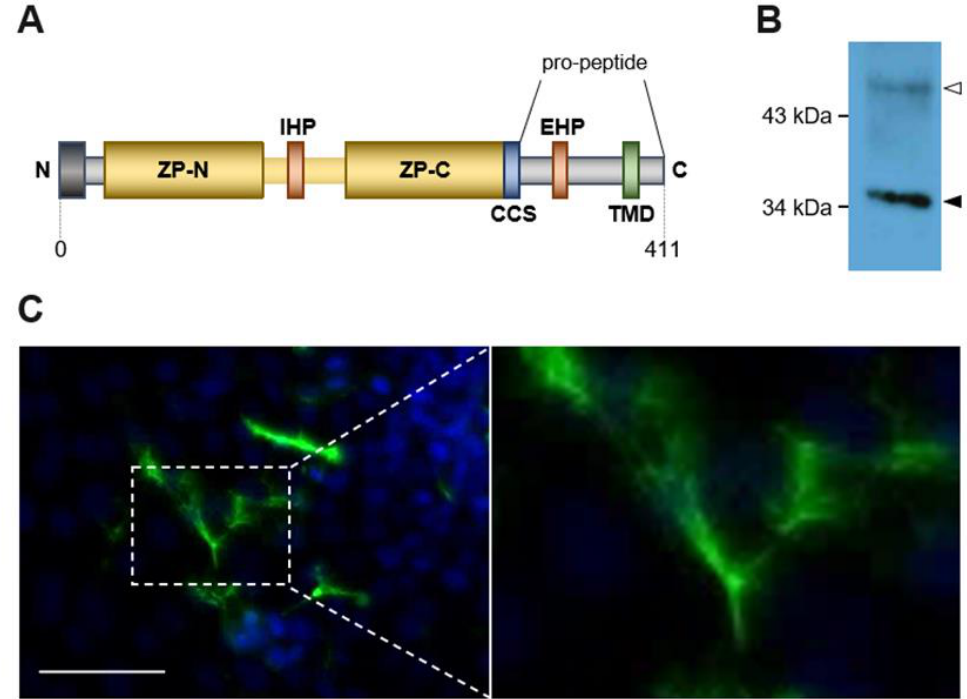
Figure 1. MDCK cells as a model to study ZPLD1. ( A ) Scheme of zebrafish ZPLD1 structure expected to contain a N-terminal signal peptide, a bipartite Zona Pellucida (ZP) module (including ZP-N and ZP-C domains) and a C-terminal pro-peptide [1]. The internal (IHP) and external (EHP) hydrophobic patches, the consensus cleavage site (CCS) and the transmembrane domain (TMD) are also indicated; ( B ) Western blot of PNGase F treated ZPLD1, purified from cell culture media of transfected MDCK cells. ZPLD1 still containing N -glycans (white arrowhead) shows up at higher molecular weight and a less discrete protein band compared to fully deglycosylated protein (black arrowhead); ( C ) Immunofluorescence image of non-permeabilized MDCK cells expressing Strep- tagged ZPLD1 stained with anti-Strep antibodies. Polymers formed by the protein are clearly detected on the cell surface, likely consisting of matrices or bundles of single filaments; scale bar, 50 µ